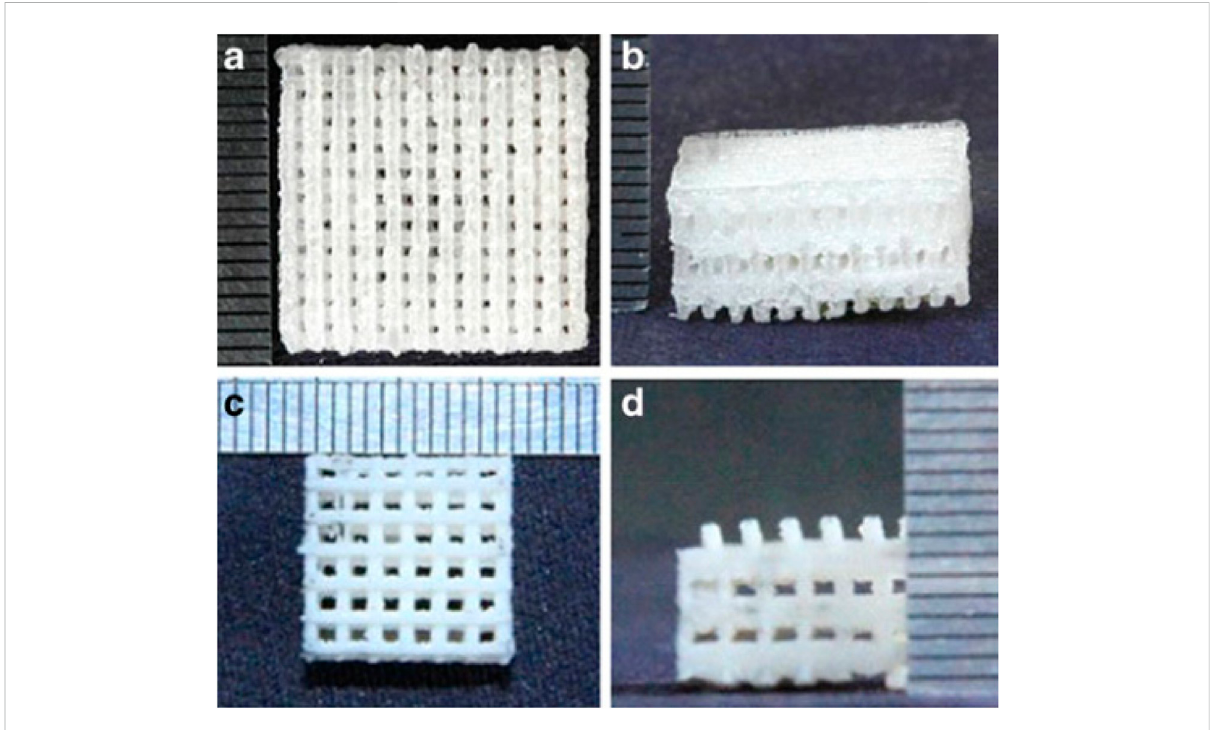
FIGURE 4 The top and front views of porous poly(lactic-co-glycolic acid) (PLGA) scaffold alone (A,B) and in combination with nano- Hydroxyapatite (HA) (C,D) (Gentile et al.,